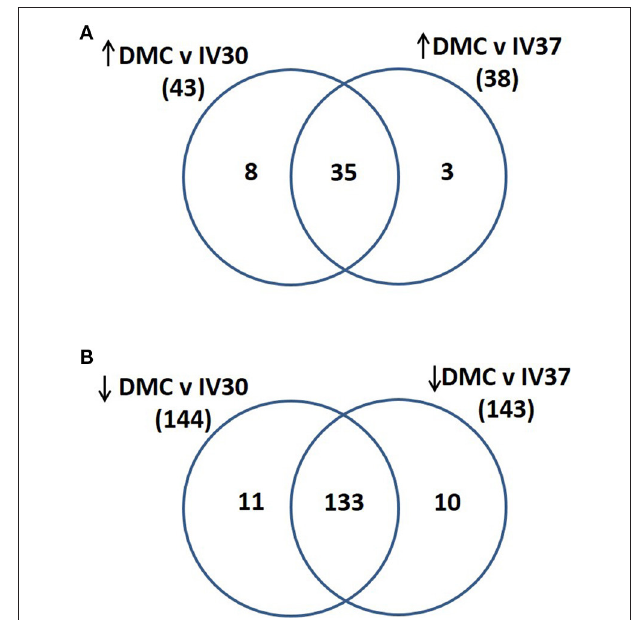
FIGURE 2 | Venn diagram illustrating the numbers of proteins that were identified as (A) increased in abundance in DMC compared to IV30 or IV37 leptospires or (B) decreased in abundance in DMC compared to IV30 or IV37 leptospires.